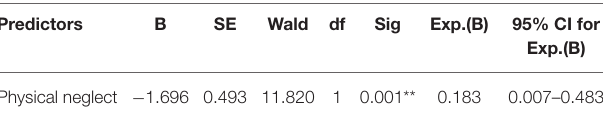
TABLE 3 | Results of the stepwise logistic analysis: independent risk factors for schizophrenic patients with suicidal